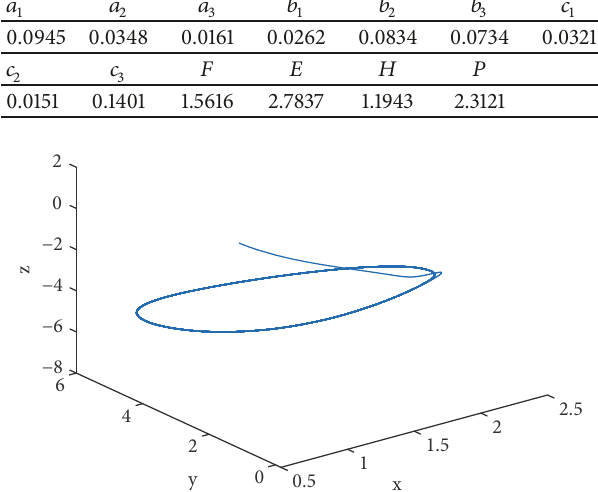
Figure 6: Three-dimensional phase diagram of system (1) with identified parameters: 3D ( 𝑥 − 𝑦 − 𝑧